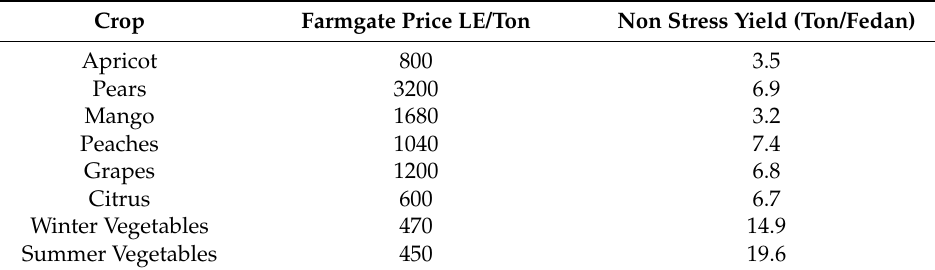
Table 16. Unit revenues from production of different crops.